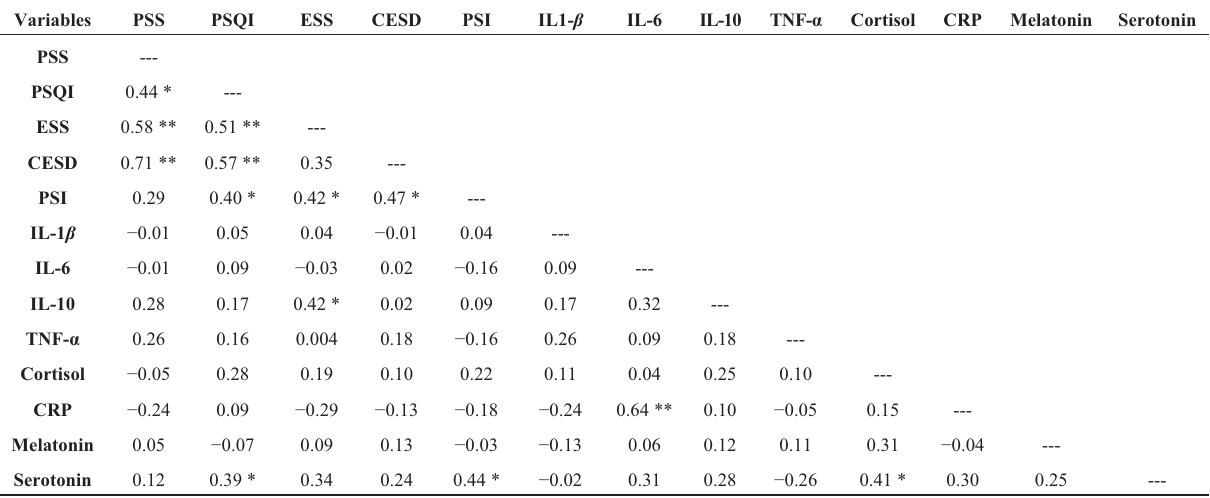
Table 4. Correlations between stress, sleep, health-related well-being, and biomarkers ( n = 29).